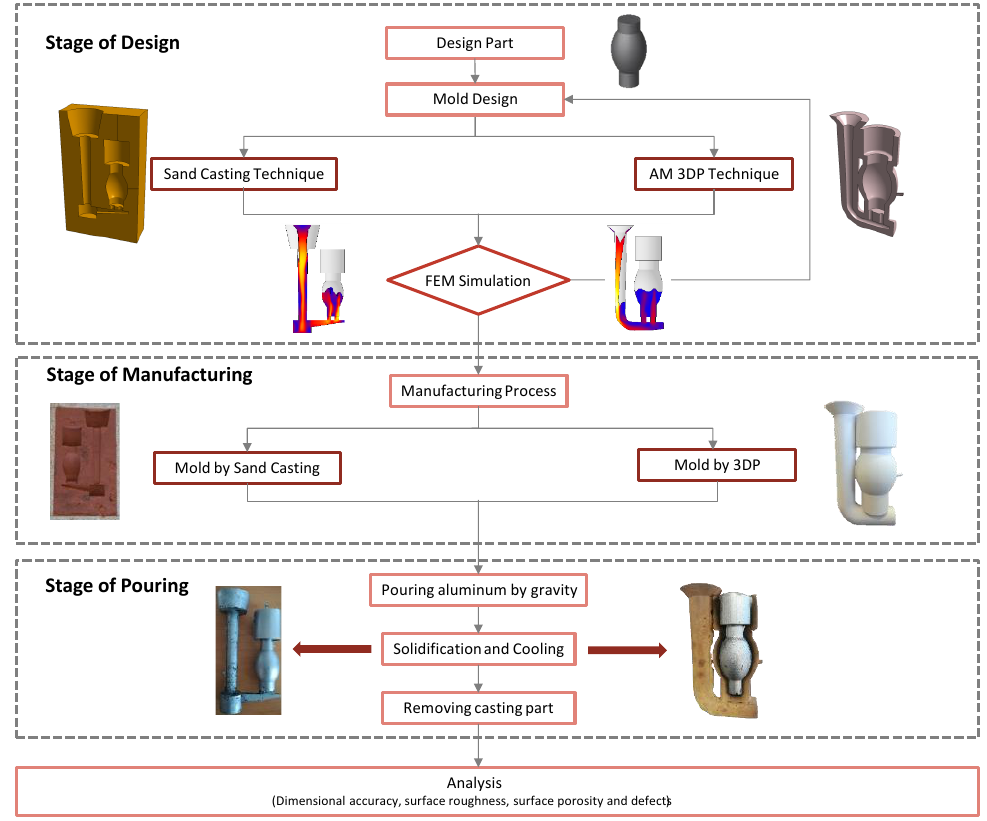
Figure 1. Methodology for the comparison between traditional sand casting and the AM 3DP technique.